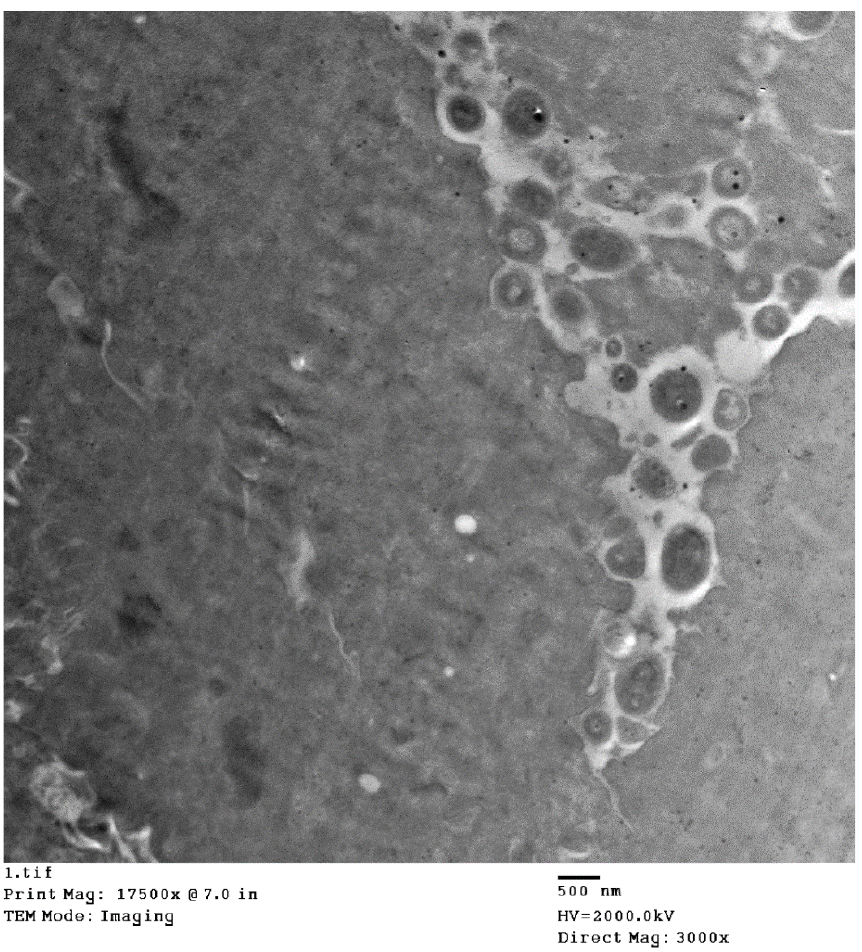
Figure 3. Electron microscopy of skin showing intra-cytoplasmic brick-shaped sheeppox virions. The serum protein fractionation of the healthy and diseased animals as well as for